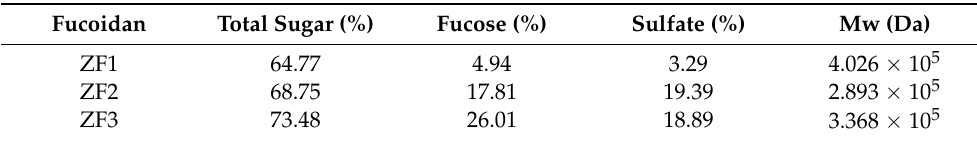
Table 5. Chemical composition and Mw of ZF1, ZF2, and ZF3. Chemical composition includes total sugar, fucose, and sulfate.